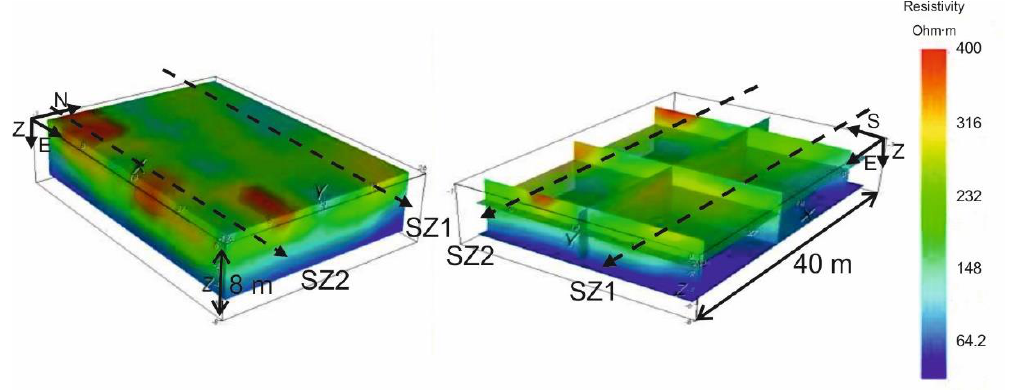
Figure 4. Three-dimensional (3D) electrical resistivity model obtained within the infiltration pond. The relative position of two-dimensional (2D) ERT acquisitions is represented as dashed